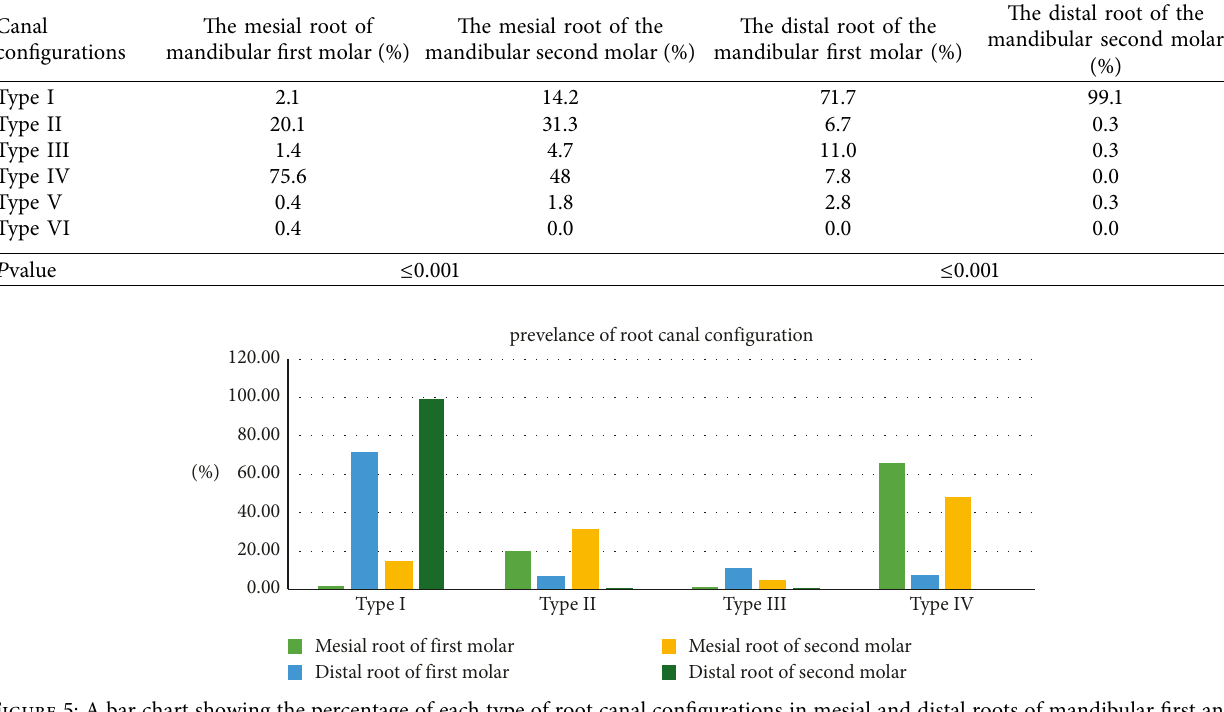
Table 4: Frequency and distribution of root canal configurations according to Vertucci’s classification.